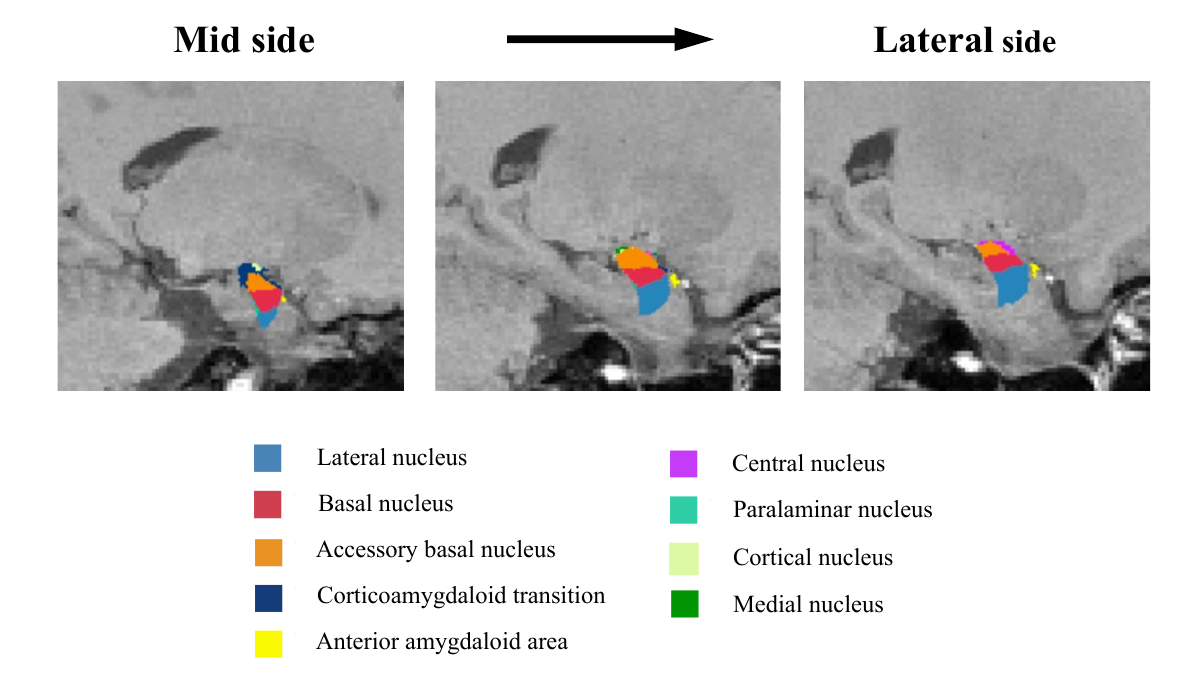
Figure 1. Anatomical amygdala subregions. Representative images of the amygdala subregions. The mask of each region is overlaid on sagittal T-1-Weighted images from the mid side to the lateral